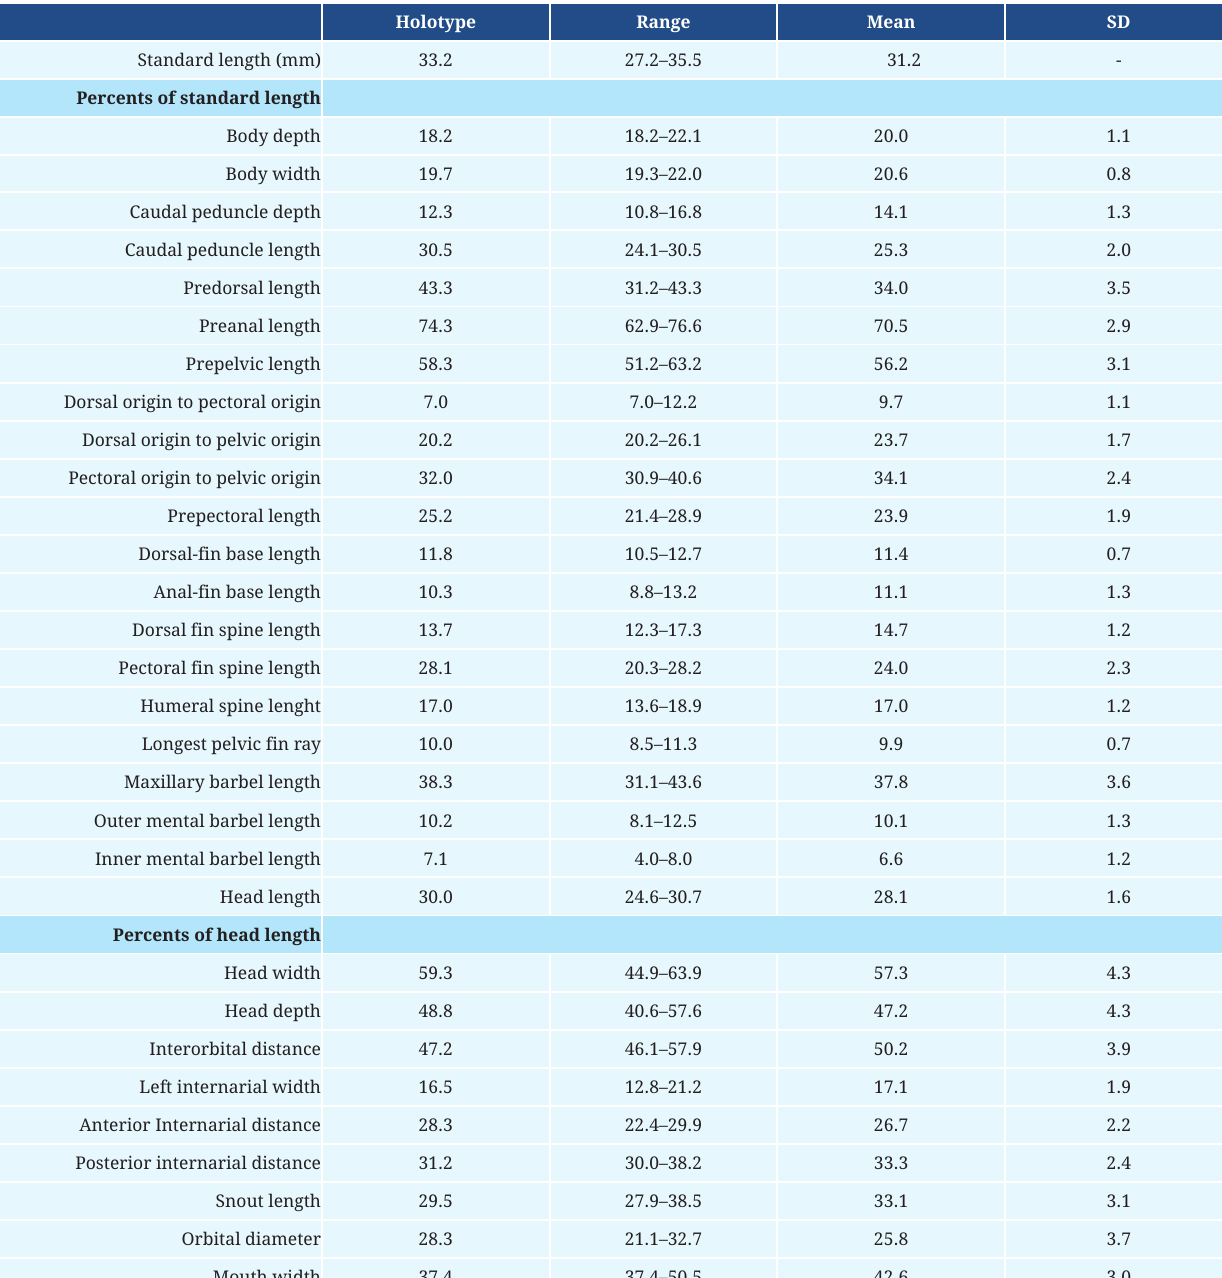
TABLE 1 | Morphometric data of holotype and 16 paratypes of Tatia akroa . Holotype included in the ranges and means. SD = Standard